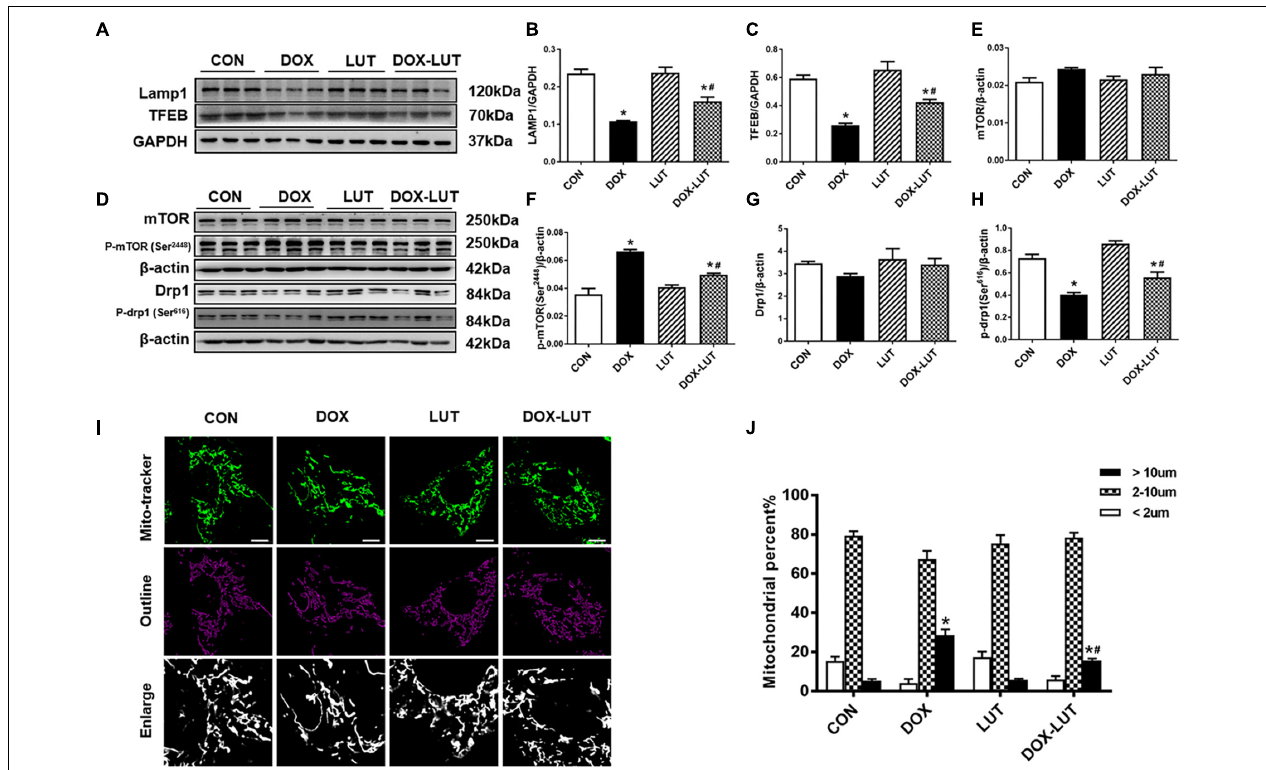
FIGURE 5 | Effect of luteolin treatment on lysosomal Drp1/mTOR/TFEB signaling cascade. (A) Representative Western blot of lysosomal generation and number including TFEB and LAMP1. (B,C) Quantitative data for TFEB and LAMP1. (D) Representative Western blot of mTOR, pSer 2448 -mTOR, Drp1, pSer 616 -Drp1. (E) mTOR; (F) p-mTOR (Ser 2448 ); (G) Drp1; (H) p-Drp1 (Ser 616 ). (I,J) Representative fluorescence images and quantitative analysis of morphology of mitochondria in neonatal mouse cardiomyocytes (NMCMs) from 6 fields (original magnification = 630 × ). Mean ± SEM, n = 3 independent experiments in duplicates per group. Scale bars = 10 µ m. * p < 0.05 vs. CON group, # p < 0.05 vs. DOX